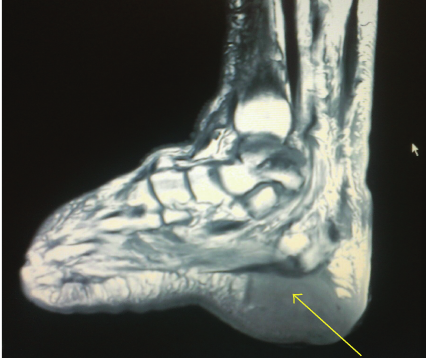
Figure 2: The MRI showed a destructive lesion in posterior part of calcaneus.